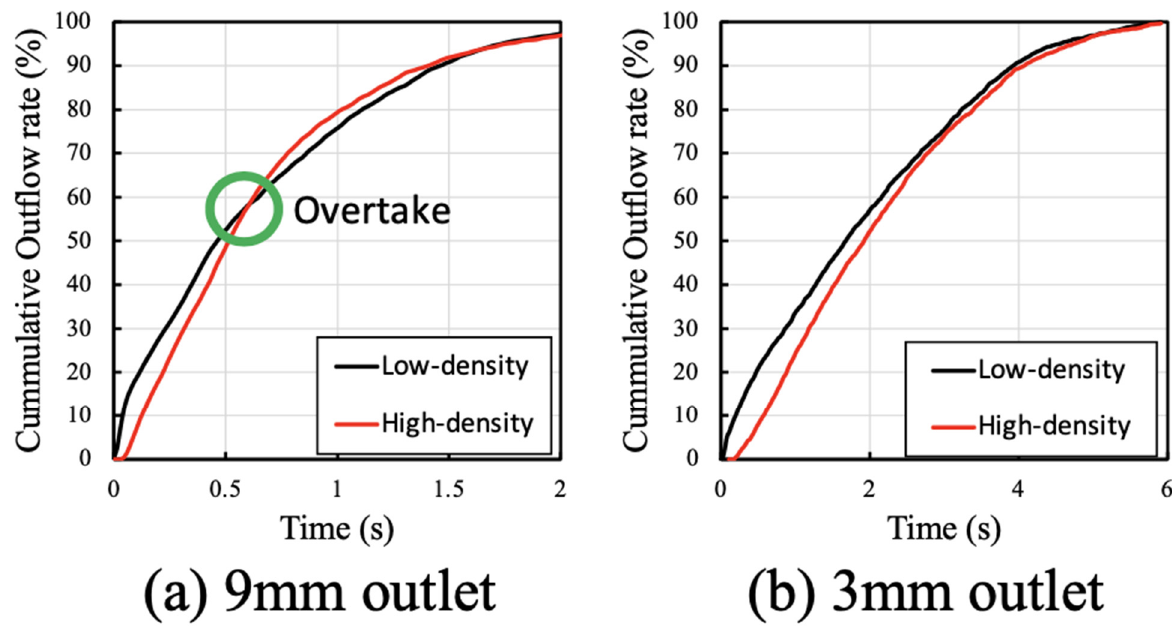
Figure 14. Outlet effect on the outflow rate in the case of the reverse density stratification.